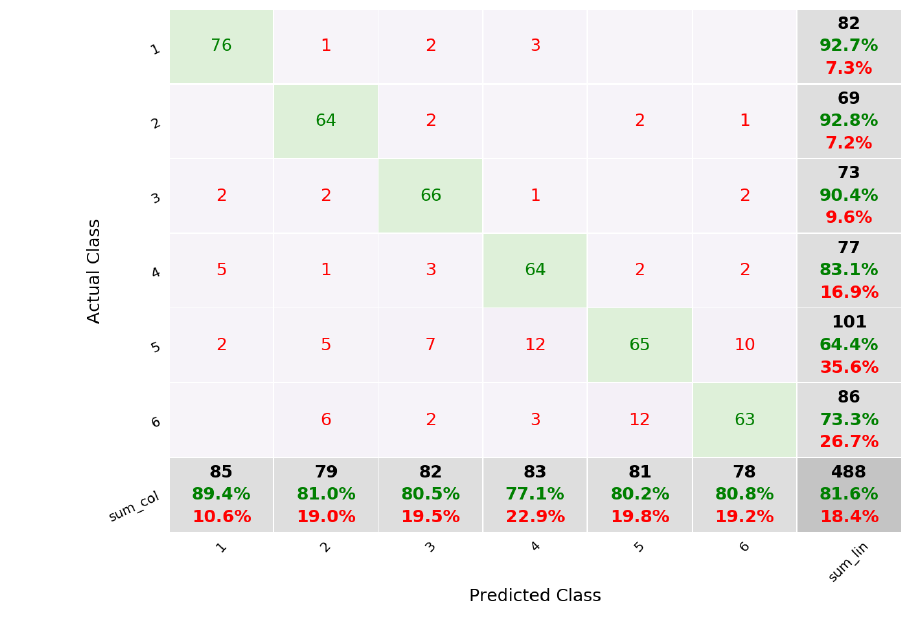
Figure 5. Confusion matrix for 6 gestures using SVM. 1—index, 2—middle, 3—ring, 4—double index, 5—double middle, 6—double